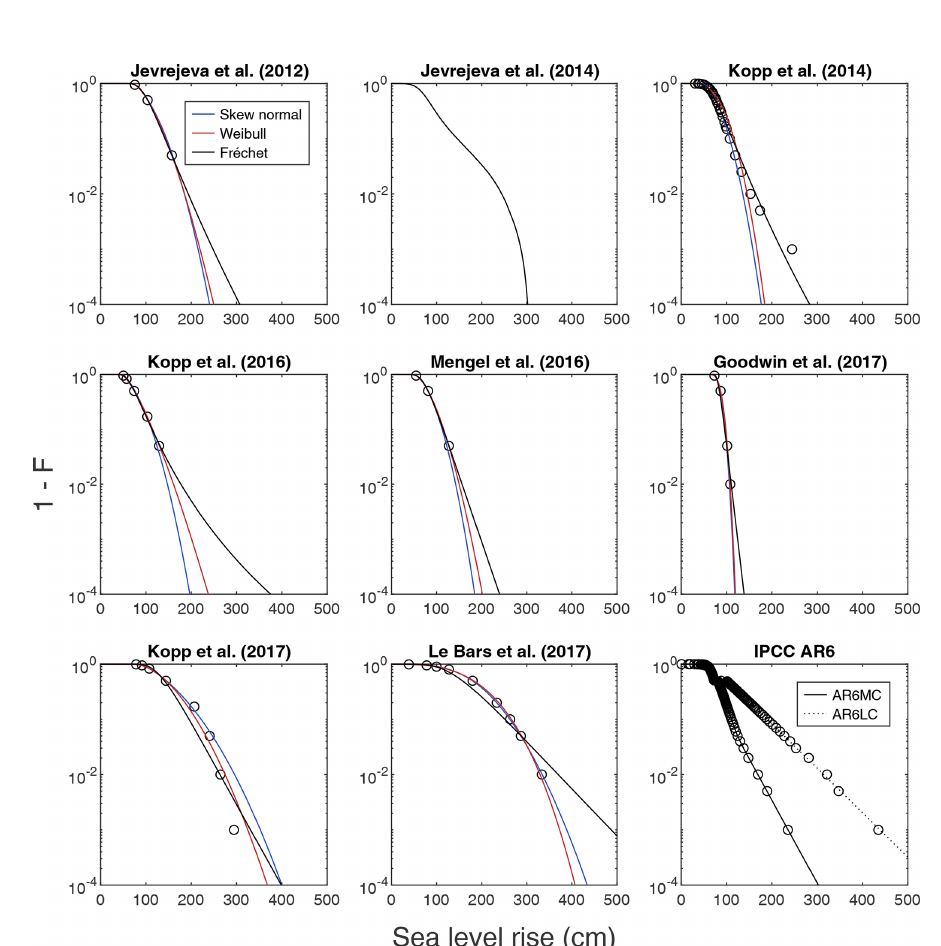
Figure A1. Members of the projection ensemble under the high-emission scenario. Fits for all three distribution types (Weibull, Fréchet, skew normal) are shown as complementary cumulative distribution functions (1 − F ). No fits were applied to Jevrejeva et al. (2014) and IPCC AR6 (Fox-Kemper et al., 2021). AR6MC and AR6LC are the medium- and low-confidence projections of IPCC AR6,